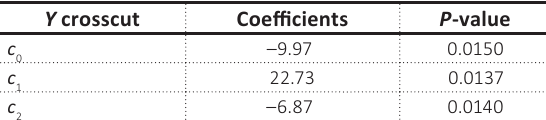
Table 2. Indicators of regression analysis of GDP/PD Y crosscut